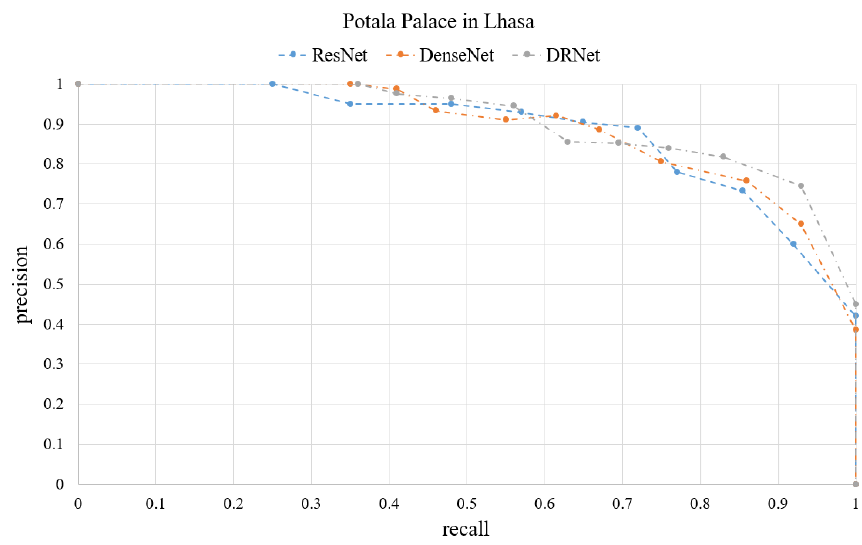
Figure 8. Precision–recall (PR) curve for Potala Palace in Lhasa.